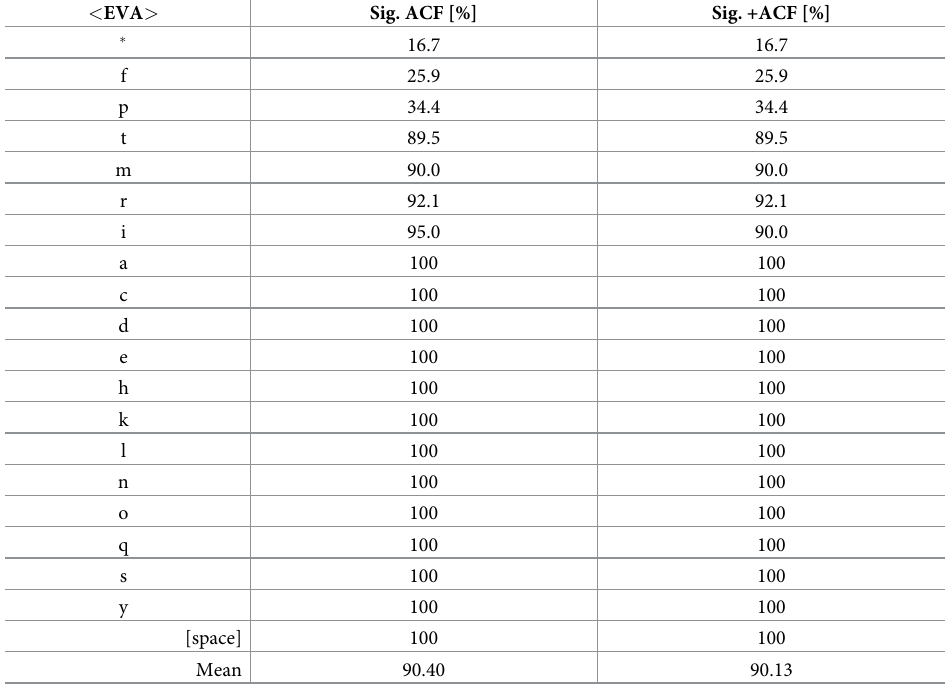
Table 3. Summarization of ACF analysis of individual symbols of the Voynich manuscript. < EVA >